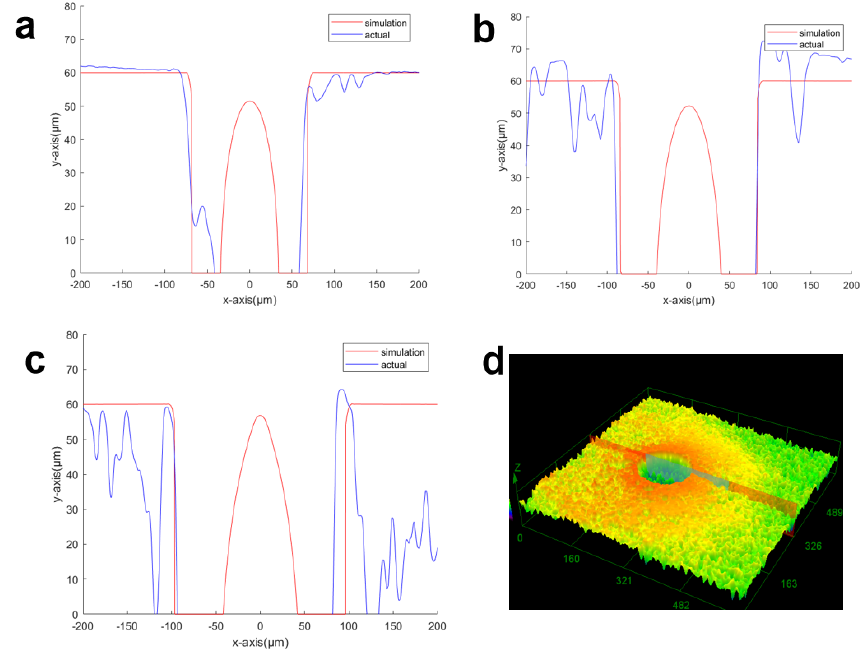
Figure 9. Comparison of the simulation and actual results under three laser parameter setups shown in Table 2. ( a ) No. a; ( b ) No. b; ( c ) No. c; ( d ) experimental results for the 3D micro hole’s shape.